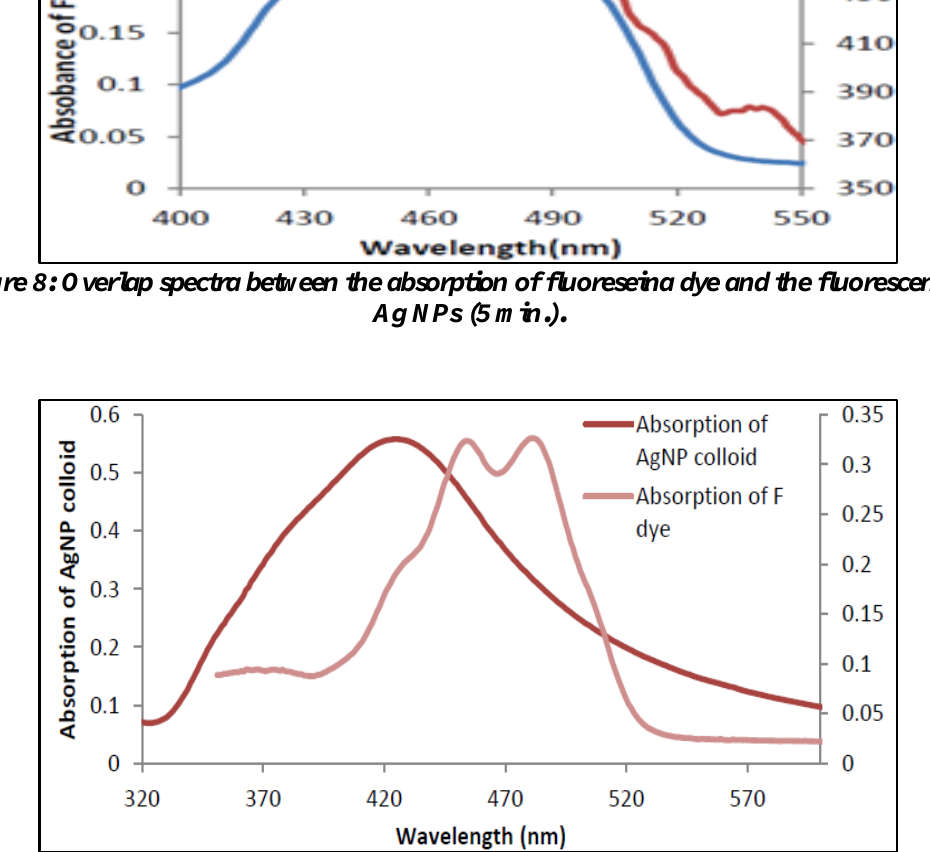
Figure 9: Overlap spectra between the surface plasmon absorption of Ag NPs (5min.) & the Absorption of fluoreseina